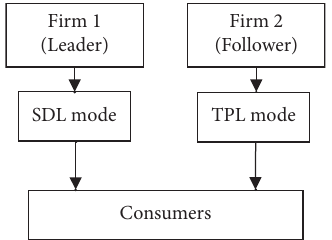
Figure 3: Logistics mode followers use TPL.